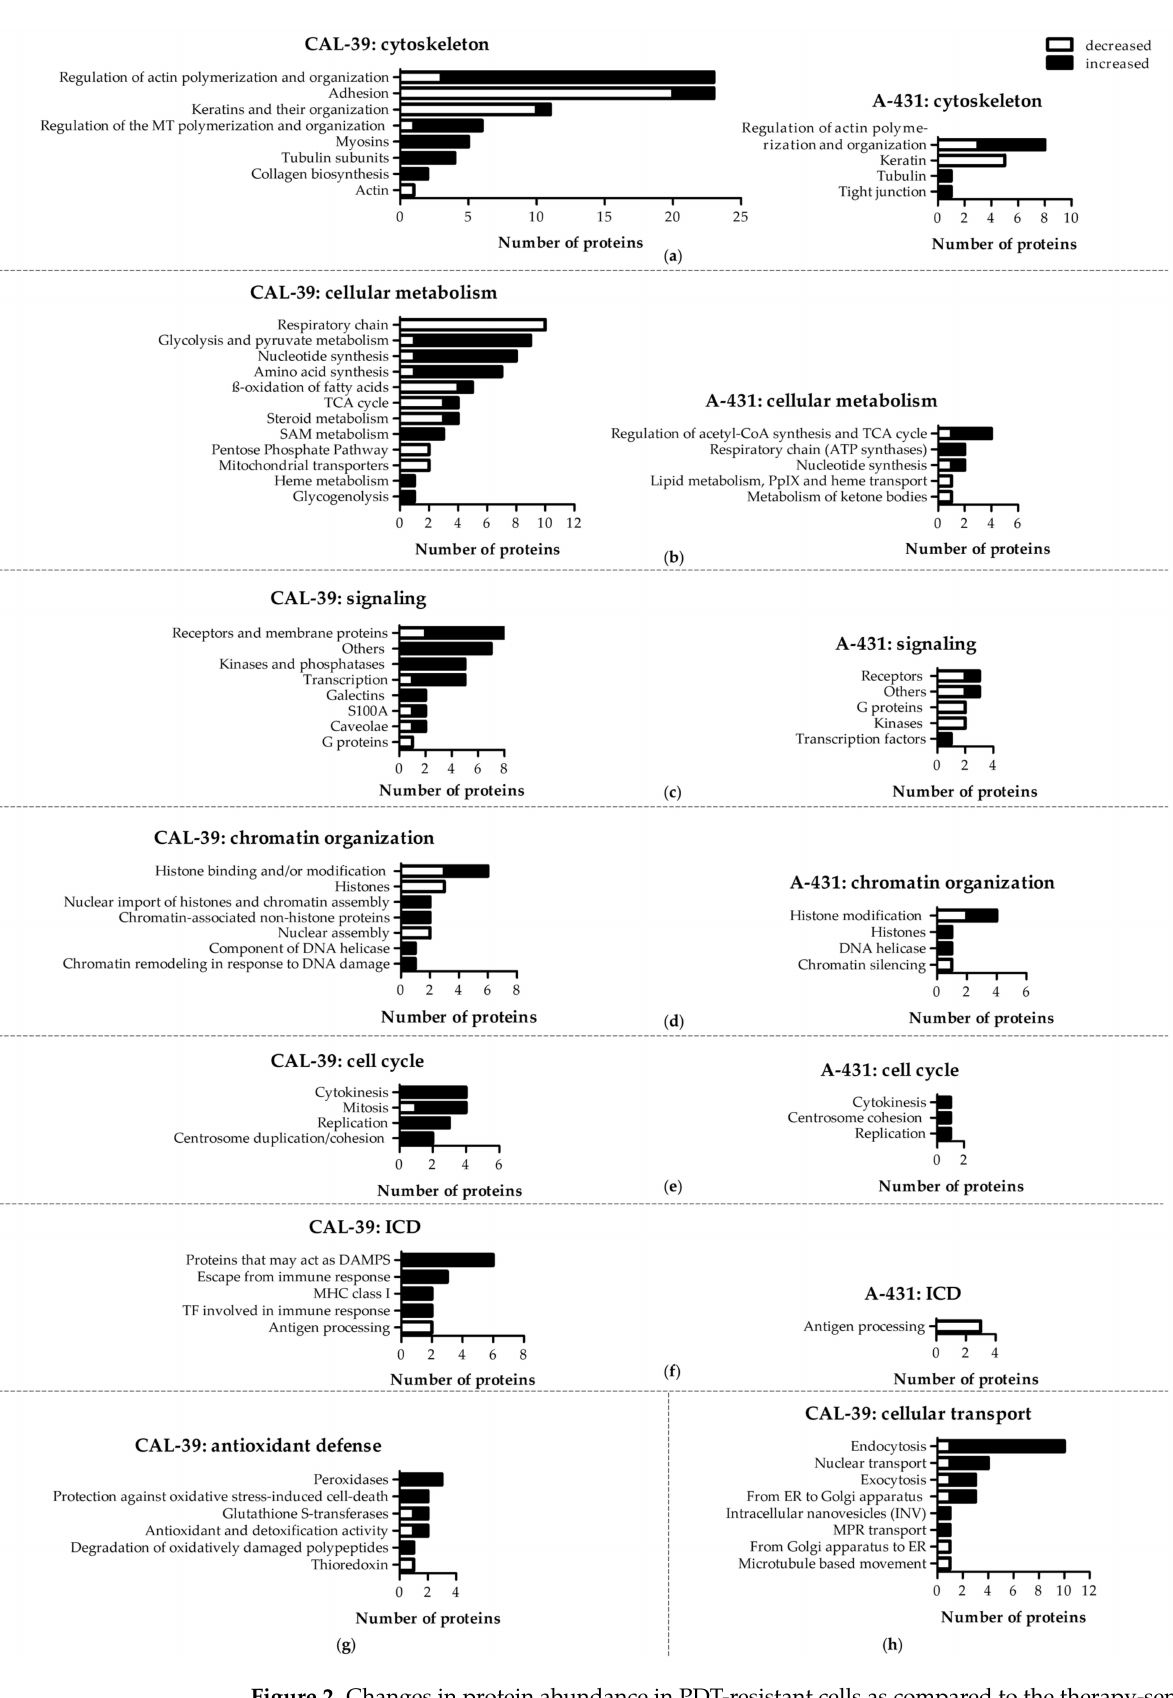
Figure 2. Changes in protein abundance in PDT-resistant cells as compared to the therapy-sensitive, parental cells. In both cell lines, this includes proteins involved in ( a ) organization and regulation